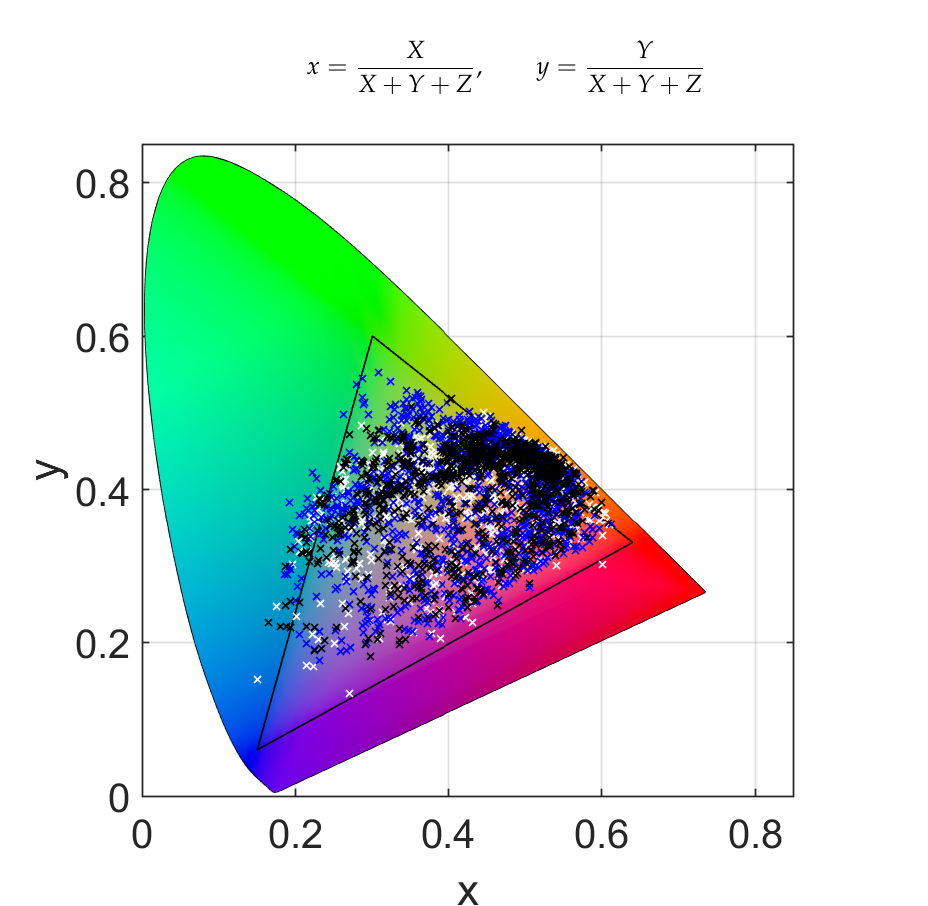
Figure 8. A 2D chromaticity plot showing the RGB colour space (triangle plot). Black crosses represent the unique colours produced by each of the model predictions made using the test data for the SiO 2 -Si 3 N 4 system. White crosses show the breadth of a 10-layer system, and blue crosses show the results of the same 6-layer system using MgO-ZrO 2 as the material